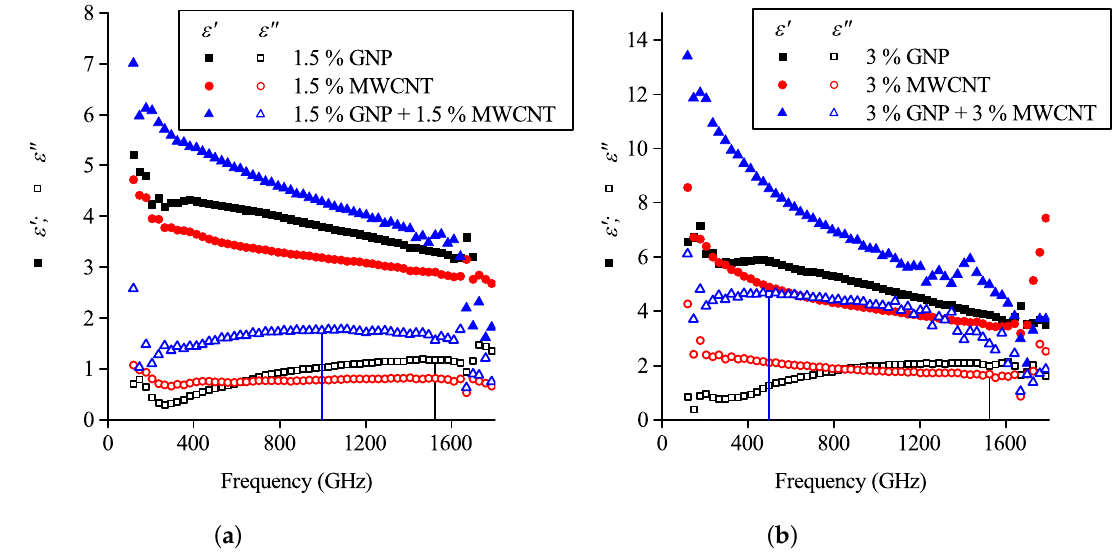
Figure 6. Complex permittivities of composites containing ( a ) 1.5% GNP, 1.5% MWCNT and their mixture; ( b ) 3% GNP, 3% MWCNT and their mixture. Peak values of ε (cid:48)(cid:48) for GNP and GNP + MWCNT composites are indicated by vertical